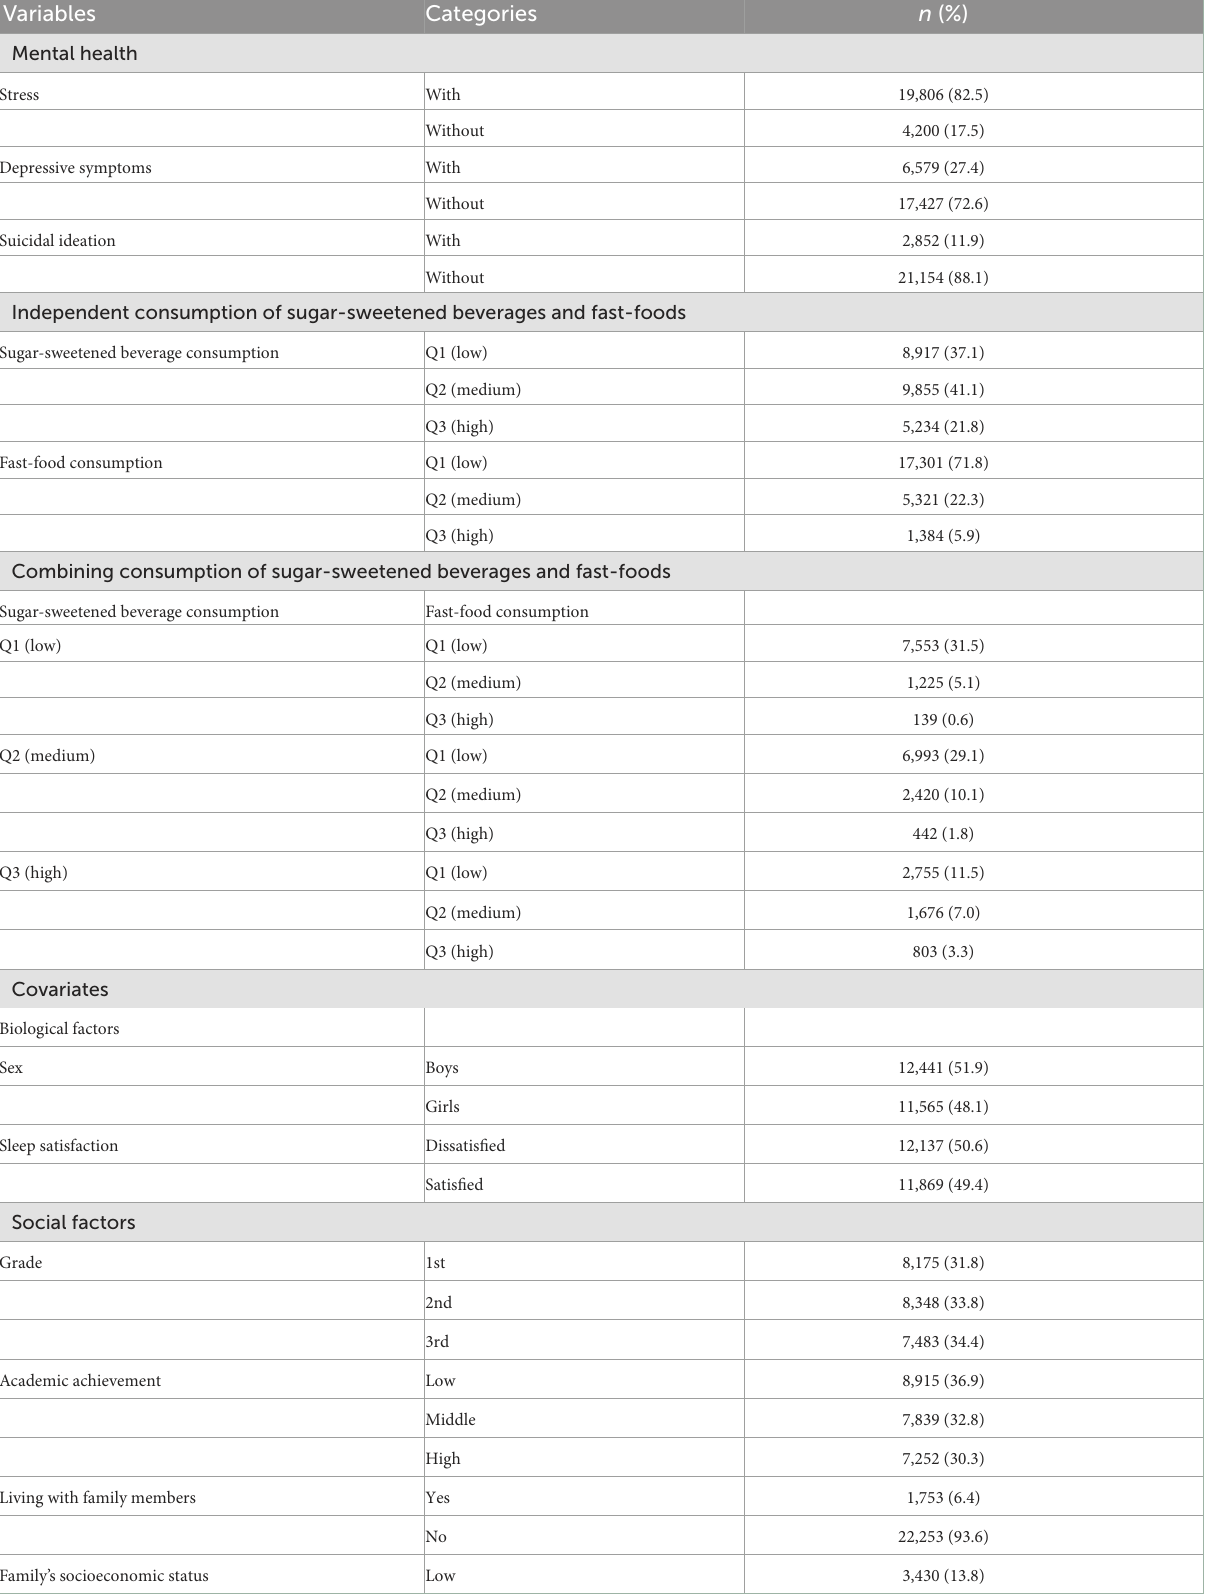
TABLE 2 Prevalence of stress, depressive symptoms, suicidal ideation, and sugar-sweetened beverage and fast-food consumption ( N = 24,006).